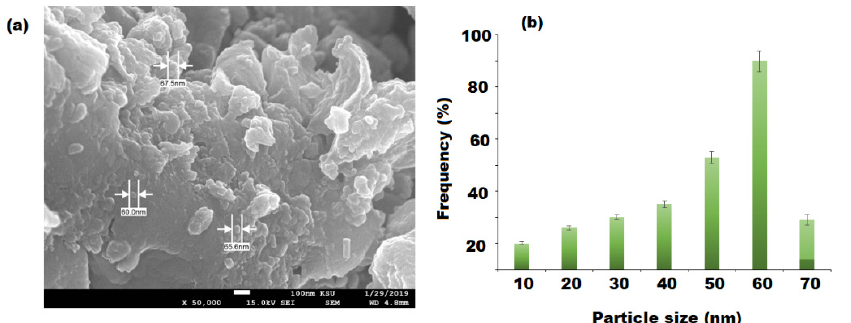
Figure 7. SEM image of ( a ) bionanocomposite containing 20 w% of nutmeg oil and ( b ) the particle size distribution and diameter of ZnONPs.